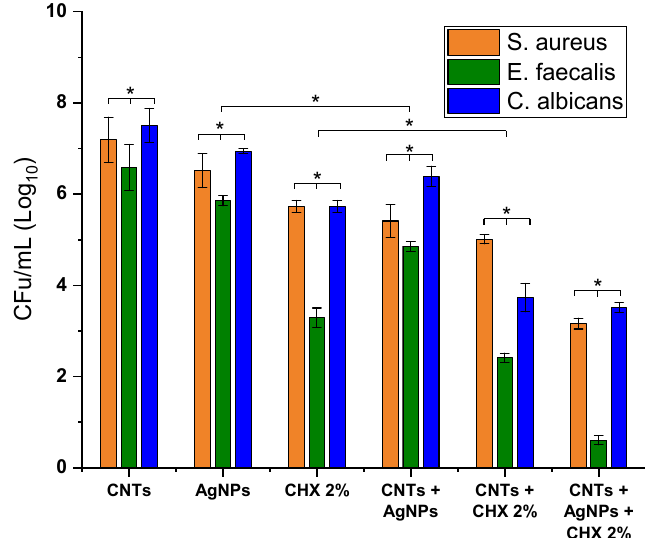
Figure 10. Antimicrobial and antifungal effect of different combinations and the mixture CNTs/AgNPs/CHX2% against the tested strains. Data are expressed as average value ± standard deviation of triplicate samples (statistical significance * p < 0.05).